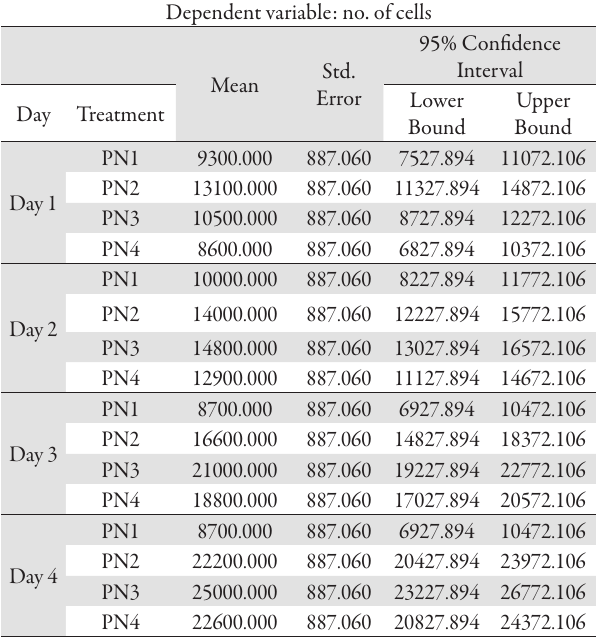
(Tab. 2) from each other, the highest growth was observed in day 4 as expected. Tab. 3 indicates that the pn3 medium produced sig- nificantly higher number of cells compared to the other three media tested in this investigation. On the other hand, pn1 medium produced significantly lower number of cells which indicates that 1.47 mM nitrogen in the form of sodium nitrate is needed for optimal growth. Tab. 4. Determination of Mean, Std. Error and 95%